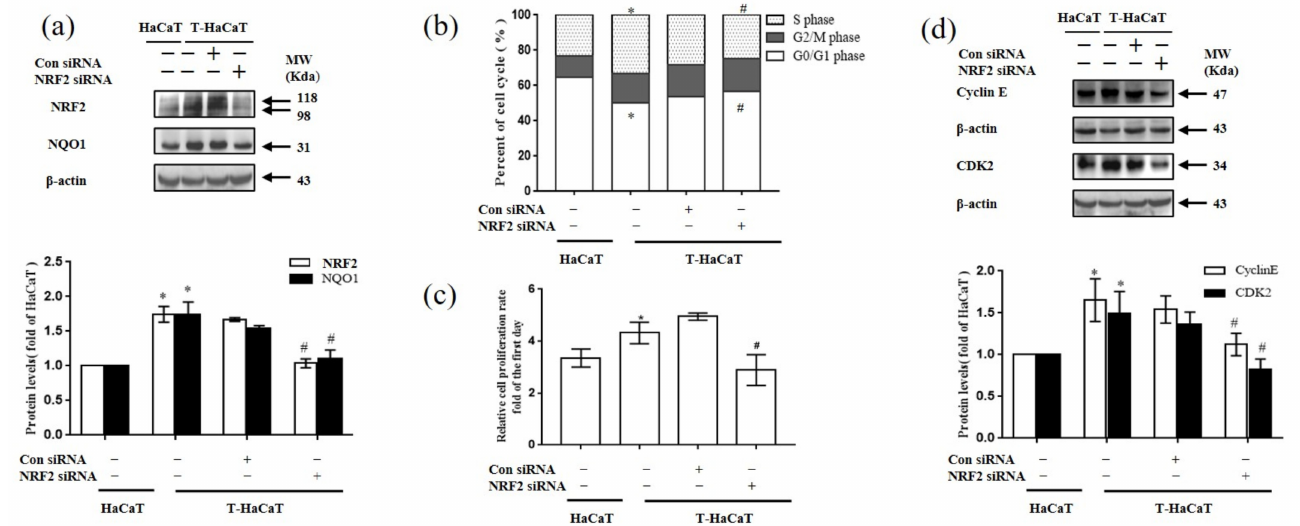
Figure 3. Effects of NRF2 on arsenite-induced malignant transformation of HaCaT cells. ( a ) Protein bands and relative protein levels of NRF2 and NQO1 in HaCaT cells and T-HaCaT cells with or without NRF2 siRNA transfection. ( b ) Changes in the cell cycle. ( c ) Change in the cell proliferation rate. ( d ) Protein bands and relative protein levels of the cell-cycle-related proteins Cyclin E and CDK2. Error bars are the mean ± SD ( n = 3). * Compared with HaCaT cells, p < 0.05; # Compared with control siRNA cells, p < 0.05.